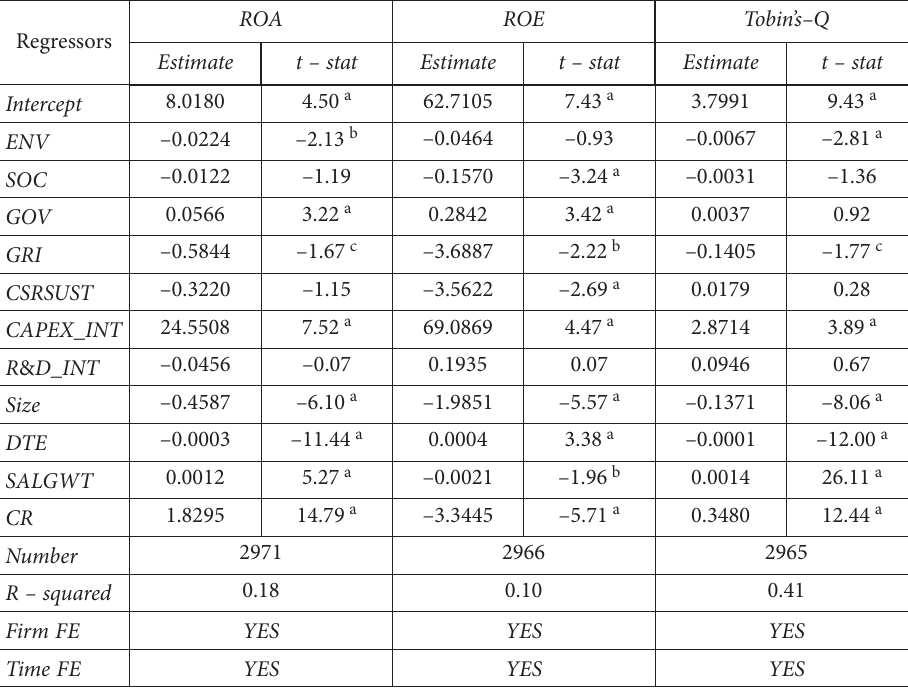
Table 5. Regression results for the sub-dimension of ESG score and financial performance mediated with GRI and CSR sustainability